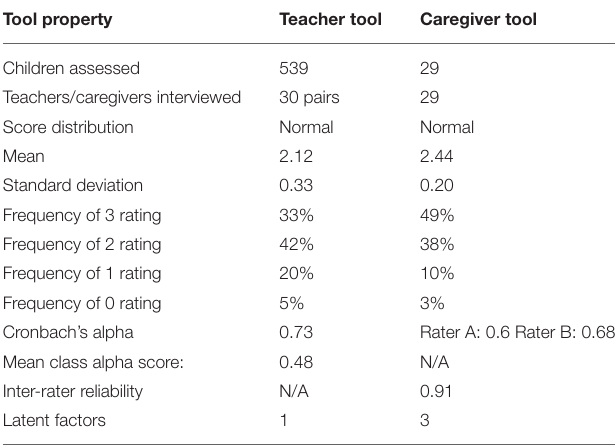
TABLE 9 | Quantitative findings of psychometric analysis of caregiver and teacher tool. Tool